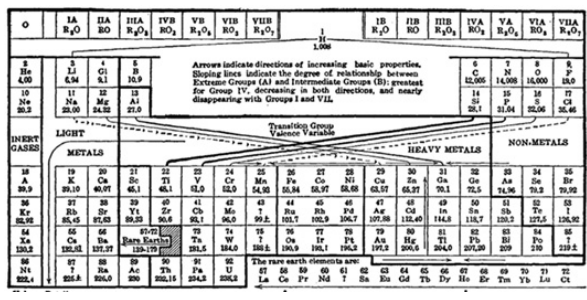
Figure 9. The Deming periodic table of 1923.